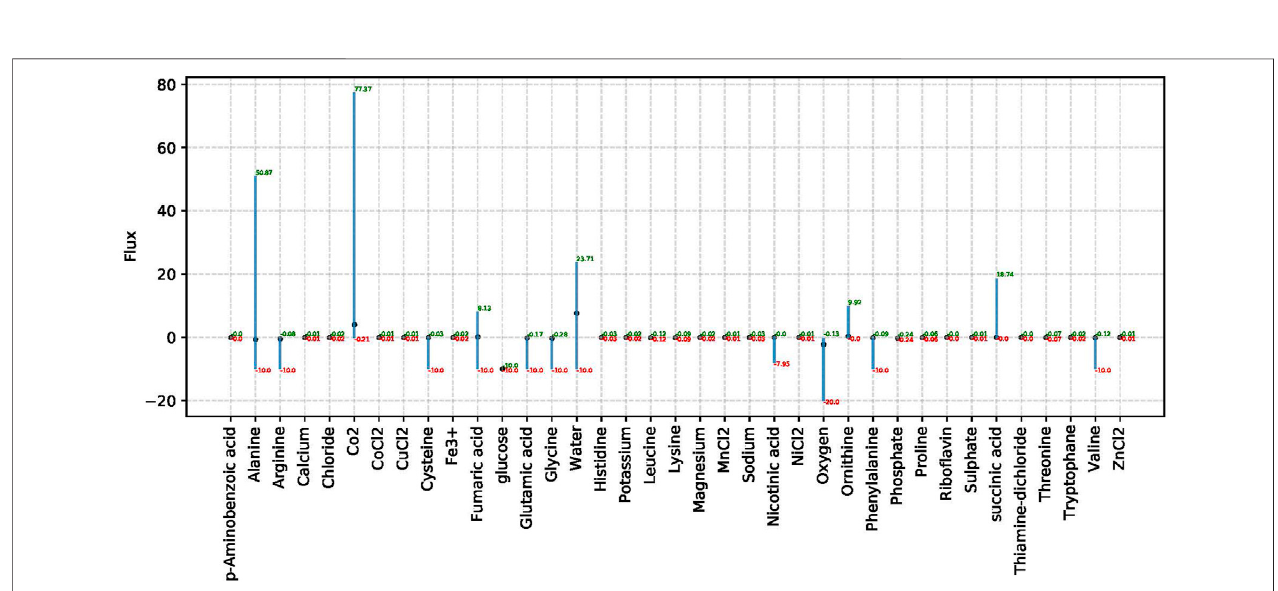
FIGURE 2 | FVA results for non-zero exchange reactions in species Dolosigranulum pigrum . This analysis only takes non-zero exchange reactions into account basedonthede fi nitionoftheSNM3.The x -axisinthisplotshowstheassociatedmetabolitestoconsiderexchangereactions,andthe y -axisshowstherespective fl uxfor the related exchange